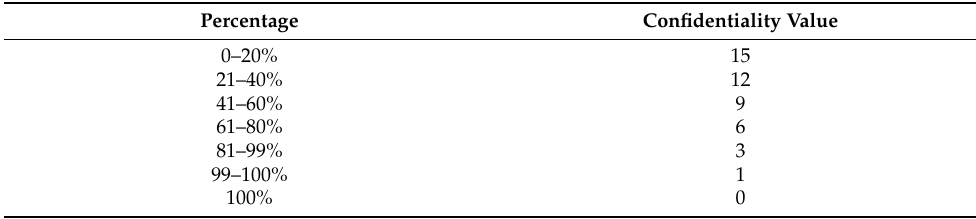
Table 6. Example of the calculation of data